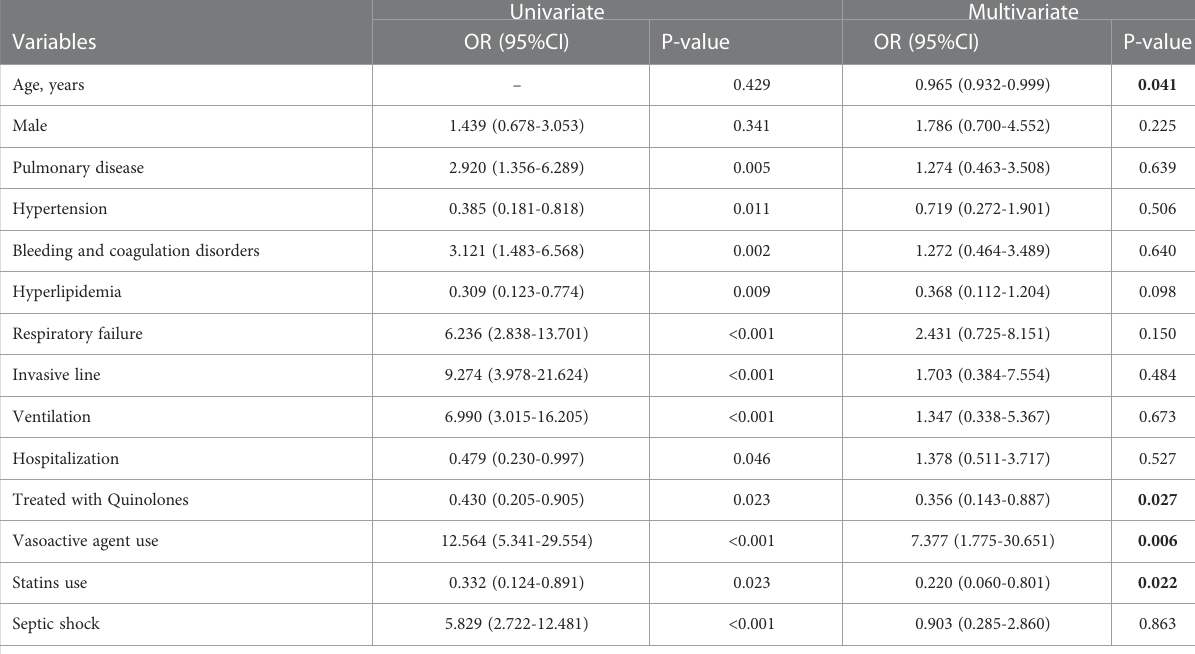
TABLE 2 Predictors for 28-day mortality in non-survival and survival group by univariate and multivariate analysis.